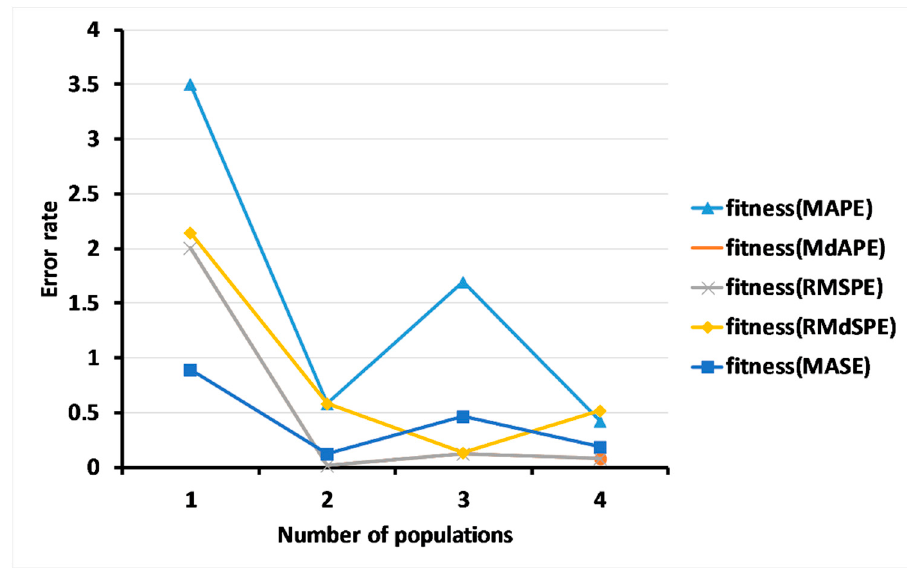
Figure 6. Labour cost error rate.